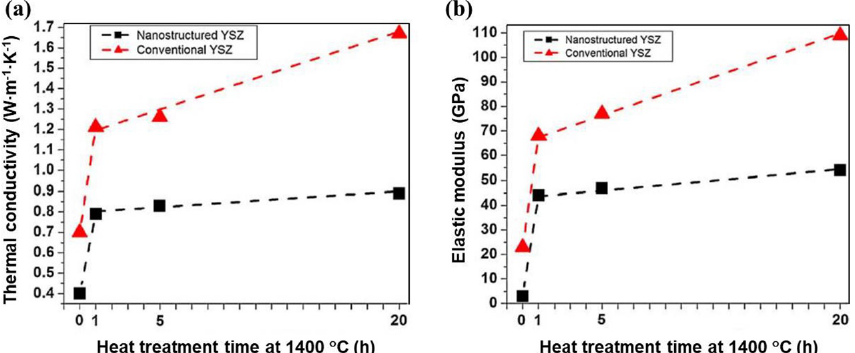
Fig. 81 Changes in (a) thermal conductivity and (b) elastic modulus during thermal exposure. Reproduced with permission from Ref. [379], © ASM International